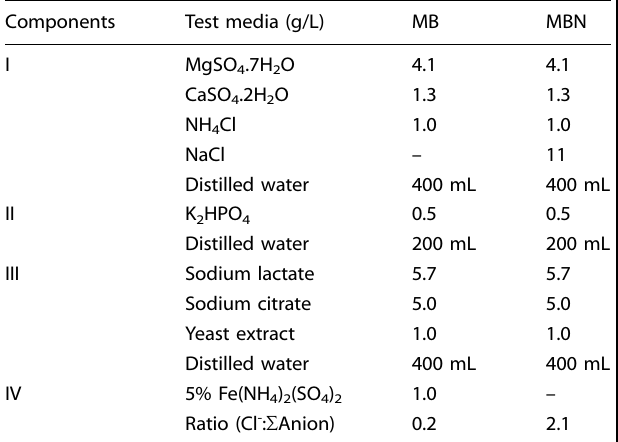
Fig. 11 Crevice assembly used to evaluate the crevice corrosion of 304 stainless steel. ( a ) Crevice assembly used in simple immersion testing, ( b ) schematic illustration of crevice washer with multiple crevice assembly (not to scale). For more detail about the crevice washer areas that are directly in contact with the surface of the stainless steel samples please see Supplementary Figs. 7 and 9. Table 3. Chemical composition of test media used for crevice corrosion studies.